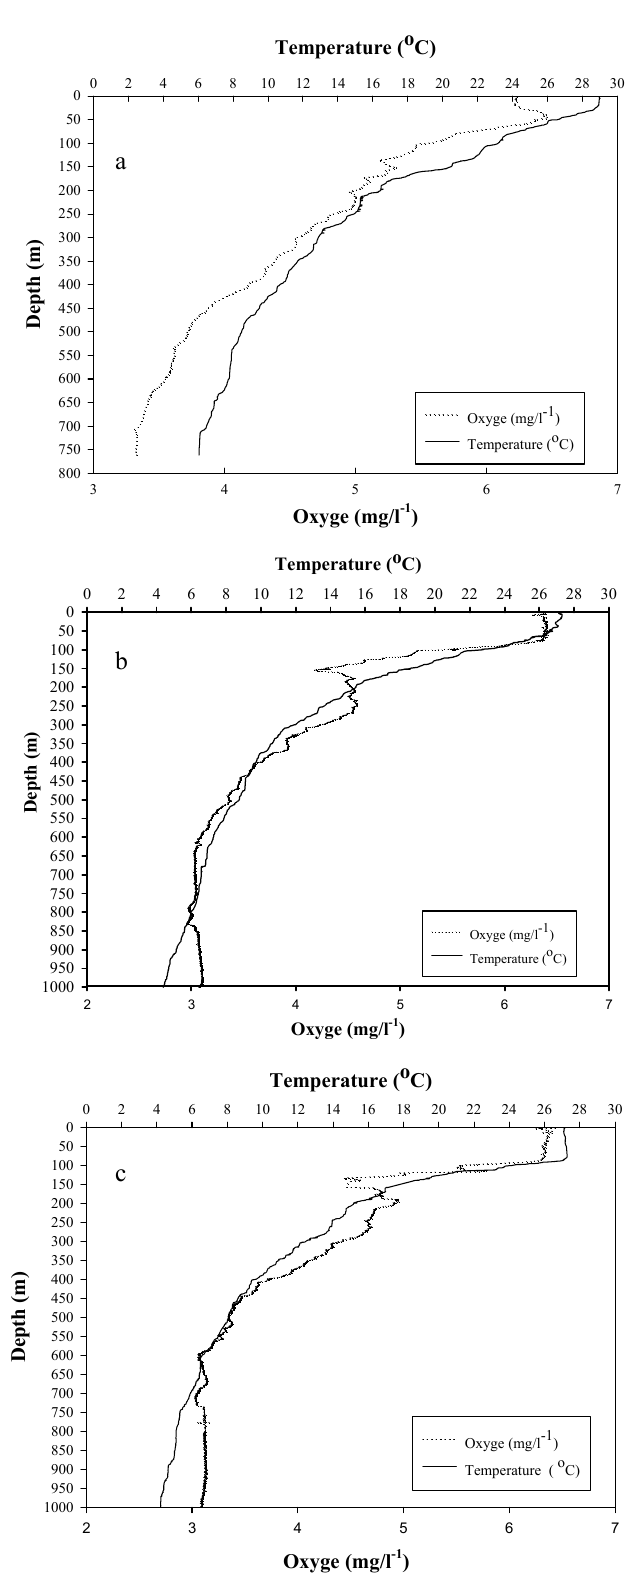
Fig. 9. Vertical pro fi leofwaterstemperature,depthandoxygenrecorded using CTD at the location where the tagged fi sh were released (22 ° 12 0 N; 119 ° 36.2 0 E). (a) August 2012, (b) May 2013, and (c) November